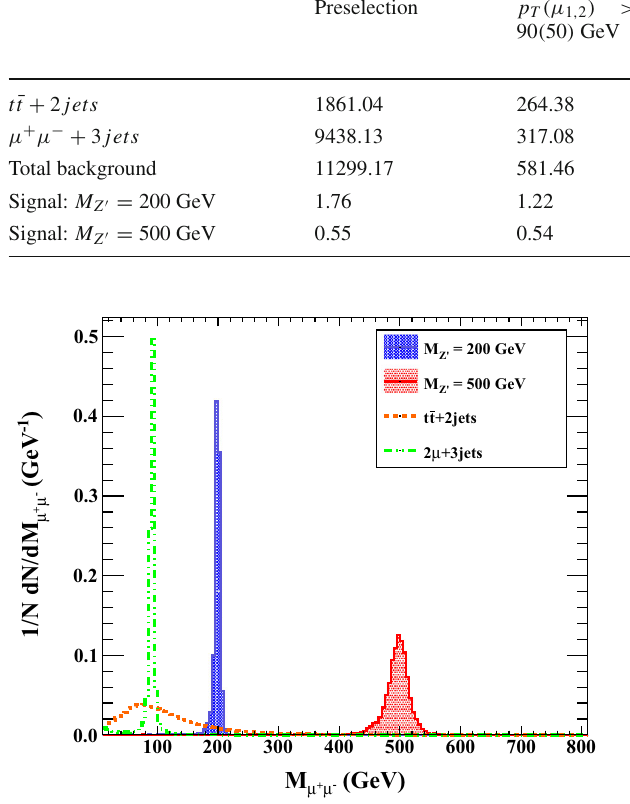
Fig. 7 Normalized invariant mass distributions of the muon-pair for signal and backgrounds